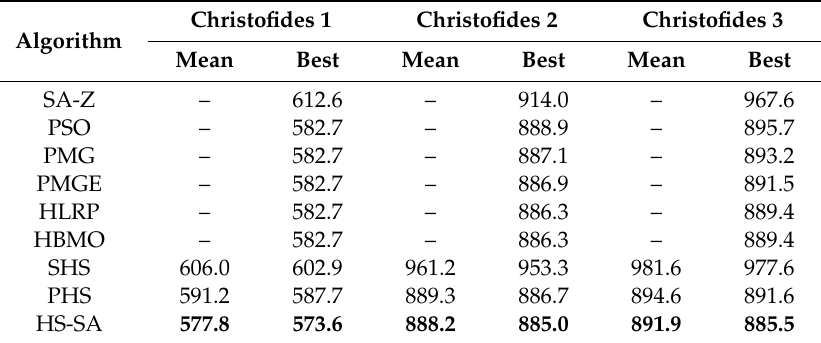
Table 5. Comparative results of Christofides dataset for